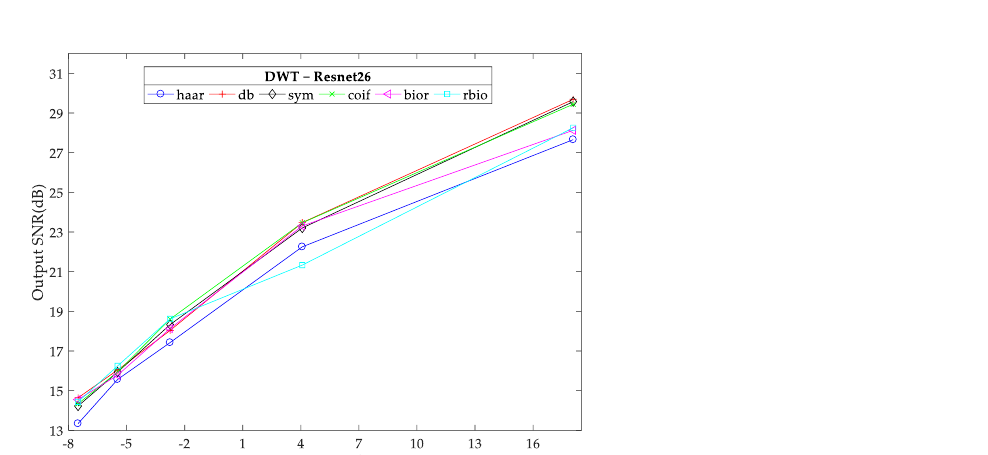
Figure 4. Trends of the best denoising results of DWT−Resnet26 with different SNRs seismic data under different wavelets.